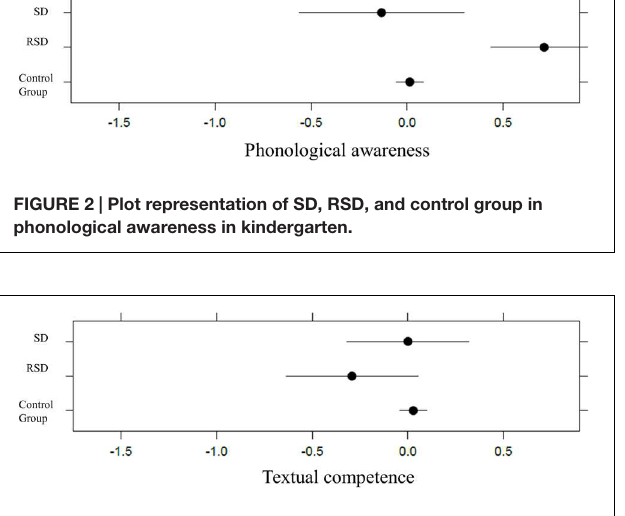
FIGURE 3 | Plot representation of SD, RSD, and control group in textual competence in